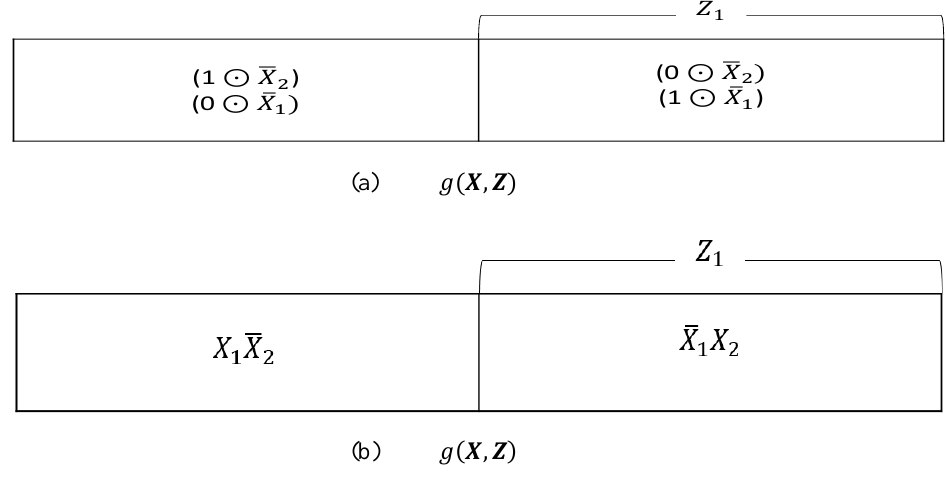
Fig. 12. Resultant of suppression of 𝑌